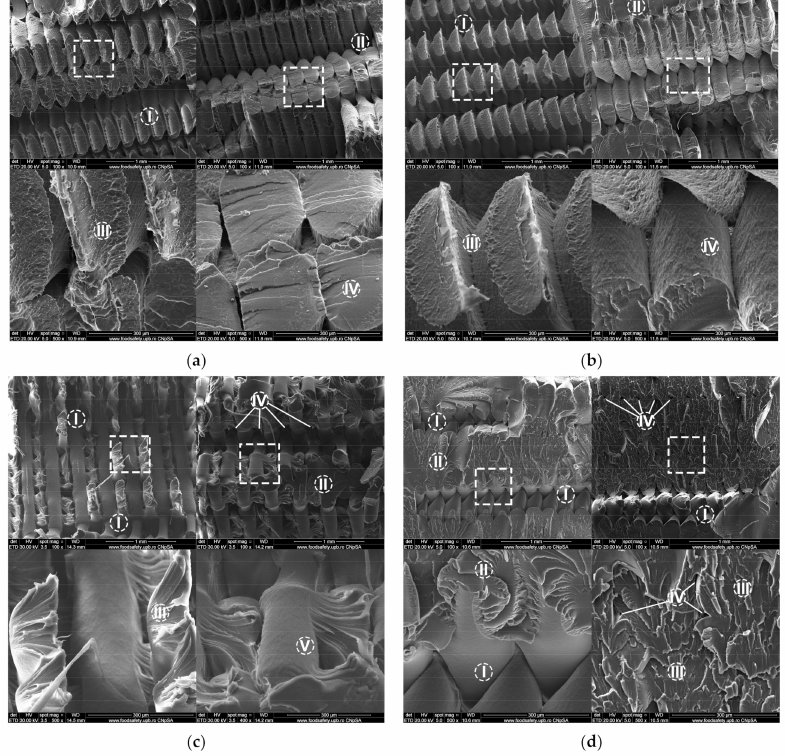
Figure 8. Scanning electron microscopy analysis of fractured 3D-printed samples: ( a ) PLA sample from control group: I—fracture along filament lines; II—filaments fractured transversally; III—sharp necking of the ruptured filaments; IV—reduced flaking at the fractured surface; ( b ) PLA sample from UV-B-exposed group: I—fracture along filament lines; II—filaments fractured transversally; III—sharp necking of the ruptured filaments; IV—increased roughness of filaments surface; ( c ) PETG sample from control group: I—fracture along filament lines; II—filaments fractured transversally; III—flaking and necking of the ruptured filament; IV—internal microvoids specific to the manu- facturing process; V—interlayer fusion; ( d ) PETG sample from UV-B-exposed group: I—fracture along filament lines; II—filaments fractured transversally; III—flaking of the ruptured filaments; IV—internal microvoids specific to the manufacturing